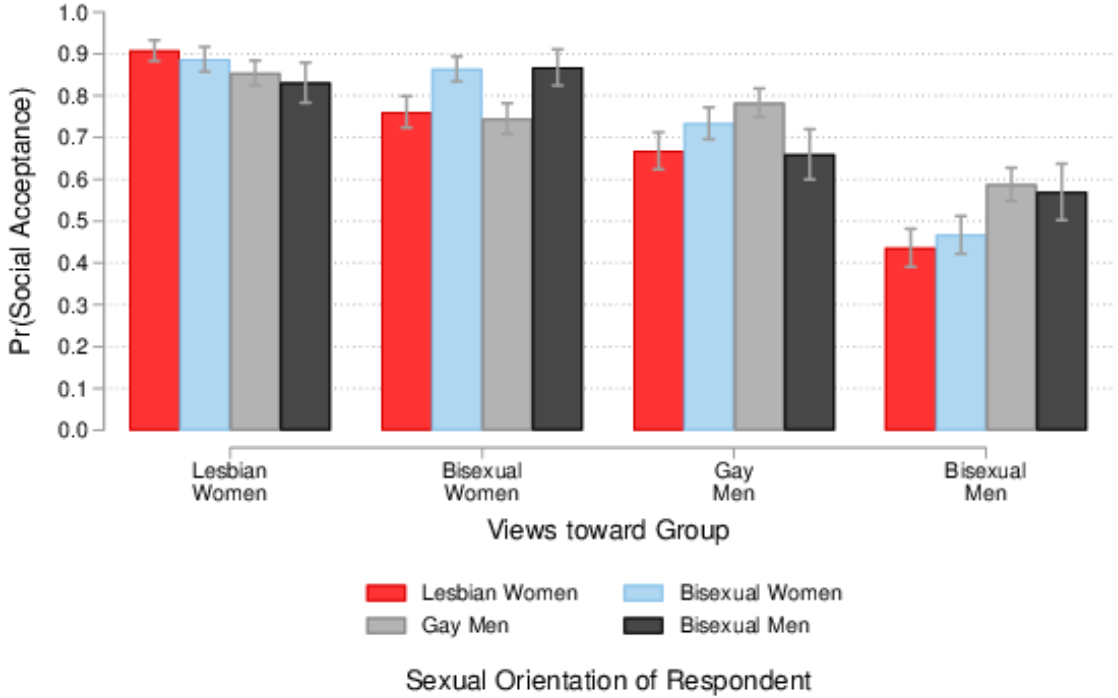
Figure 2: Predicted probability of viewing group as socially accepted (groupings represent perceptions of that group; separate bars are sexual orientation identity of the respondent). Note: Error bars represent ± 1 standard error of the